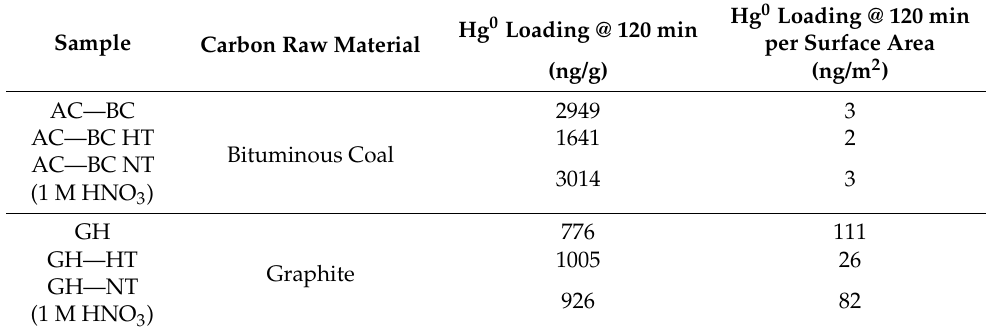
Table 5. Mercury removal comparison of bituminous coal-based activated carbon versus